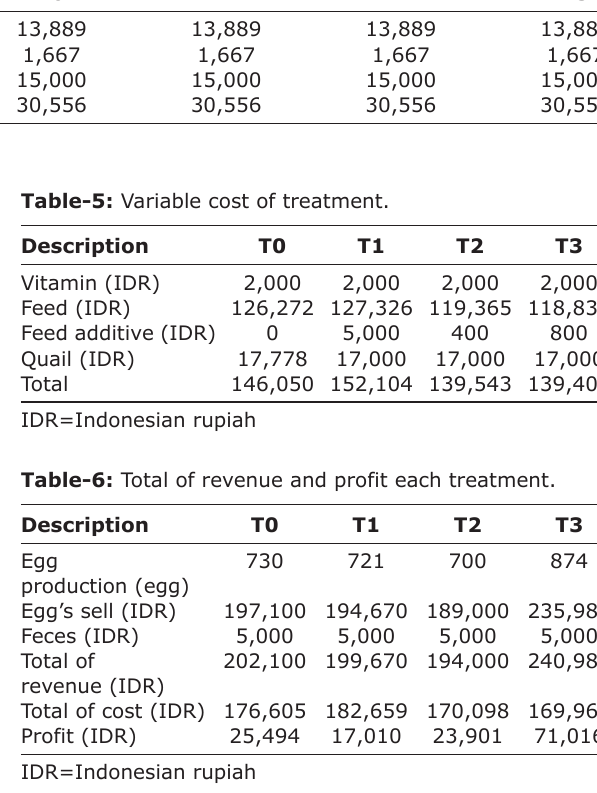
Table-4: Fix cost of treatment. Description